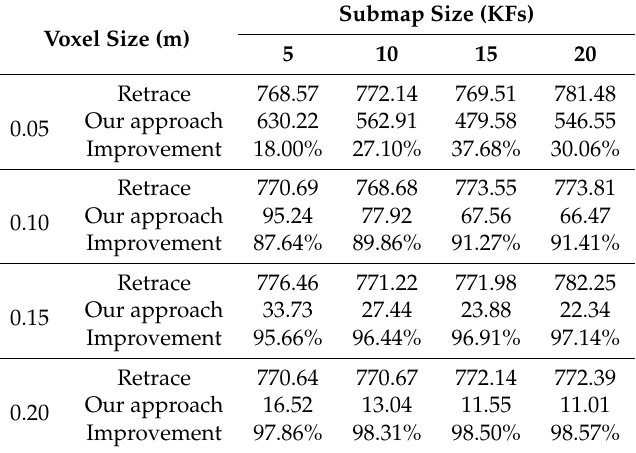
Table 3. Memory costs of the retrace approach and our method with various voxel sizes and submap sizes (MB).